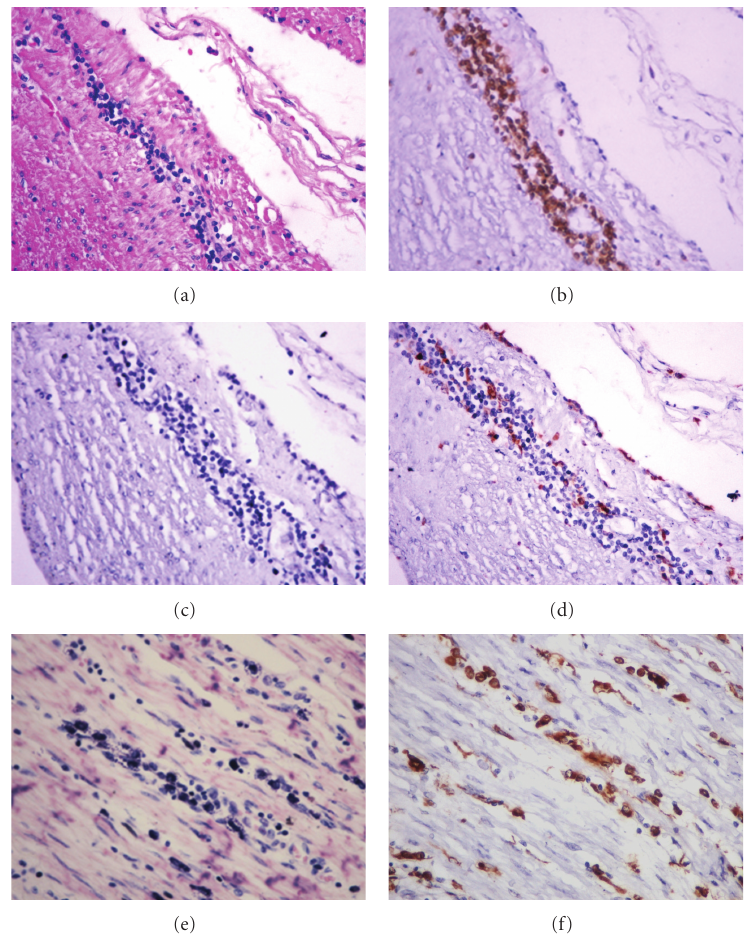
Figure 2: (a)–(d) Myositis in esophagus without mega. Note that the infiltrate is predominantly mononuclear ((a) HE—400x), with intense predominance of T lymphocytes ((b) immunohistochemistry for CD3—400x); extremely rare B lymphocytes ((c) immunohistochemistry for CD20—400x), and few positive CD68 cells ((d) immunohistochemistry for CD68—400x). (e) Numerous mast cells in the perimysium and in the foci of myositis in a case of megaesophagus can be seen (Giemsa—400x). (f) Compare this section stained by immunohistochemistry for CD68 with the previous figure, showing that both macrophages and mast cells are CD68 positive